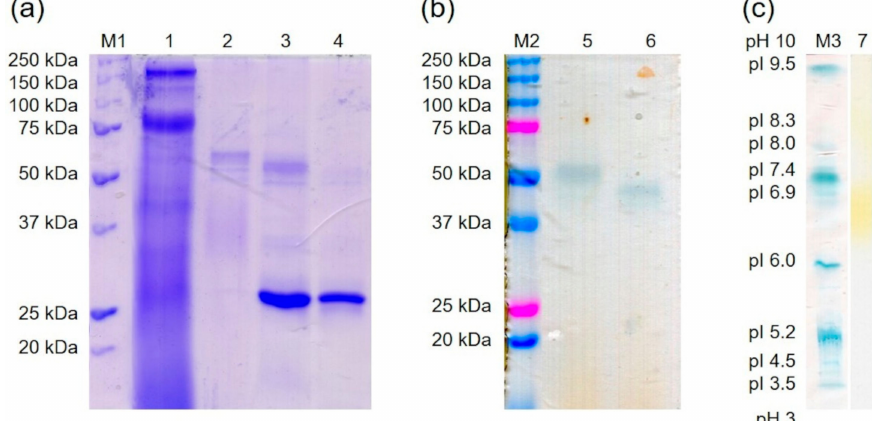
Figure 4. Purification of the recombinant PsaPOX by Ni-IMAC. ( a ) SDS-PAGE stained with Coomassie Brilliant Blue. 1: flow through, 2: elution fraction, 3: elution fraction incubated with EndoH, 4: EndoH, M1: molecular mass marker. ( b ) Semi-native PAGE stained with ABTS in the presence of